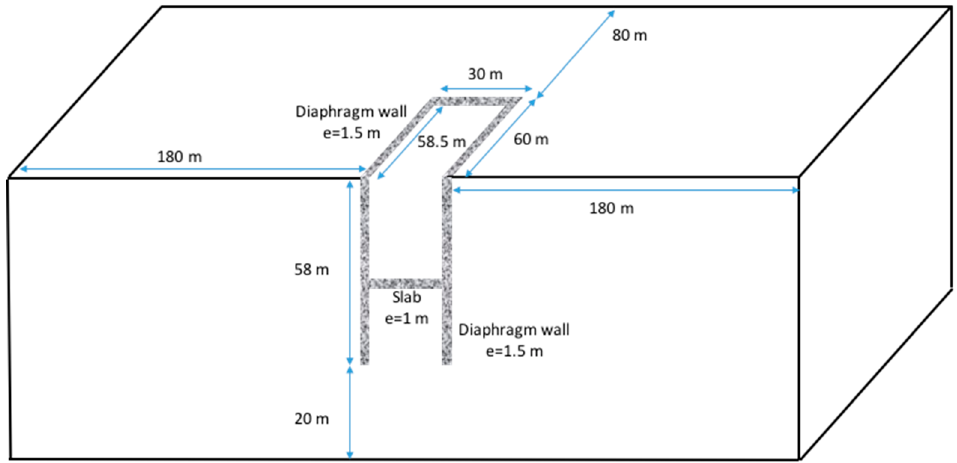
Figure 5. Geometry under consideration.